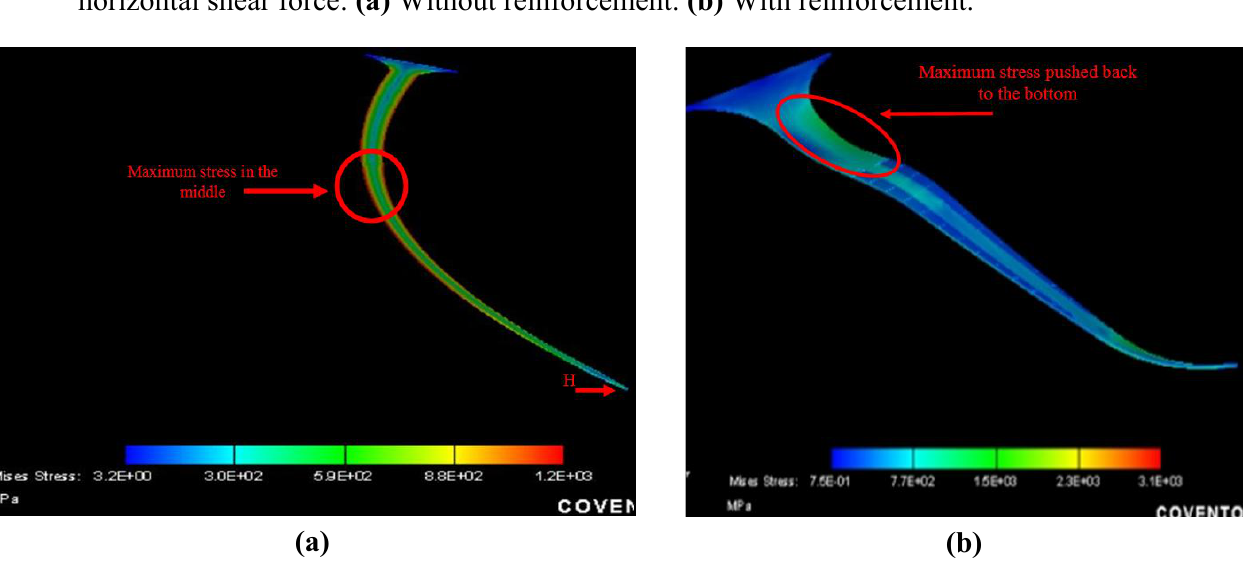
Figure 11. Behavior of the 6.5mm long and 10 µm thick electrode when it is subjected to horizontal shear force: (a) Without reinforcement. (b) With